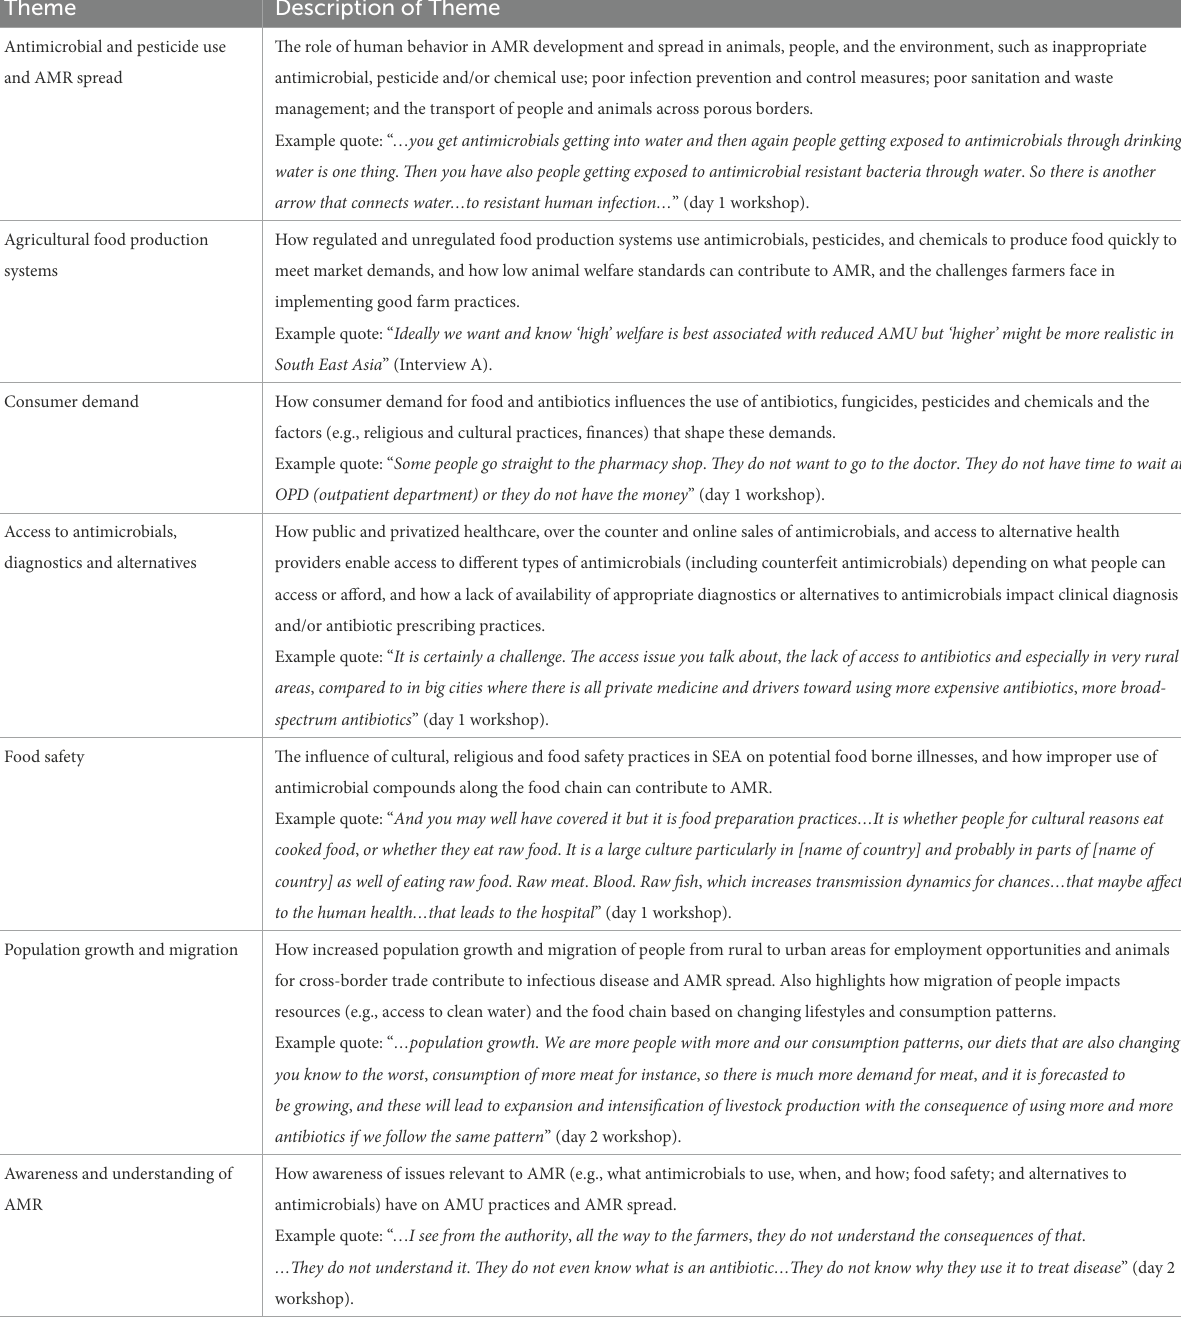
TABLE 1 Themes based on participant